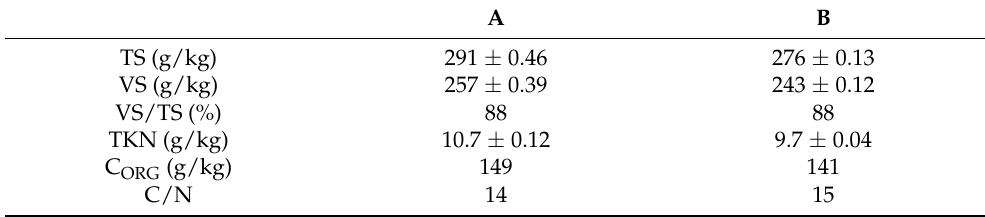
Table 1. Characterisation of samples A and B.